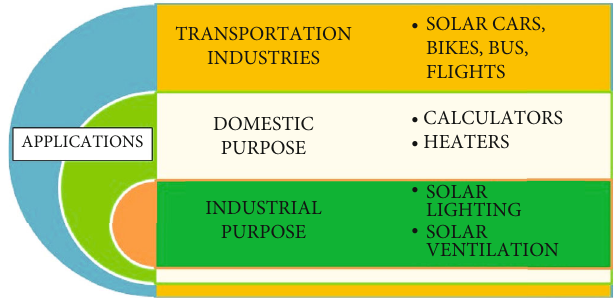
Figure 1: Applications of solar cell.